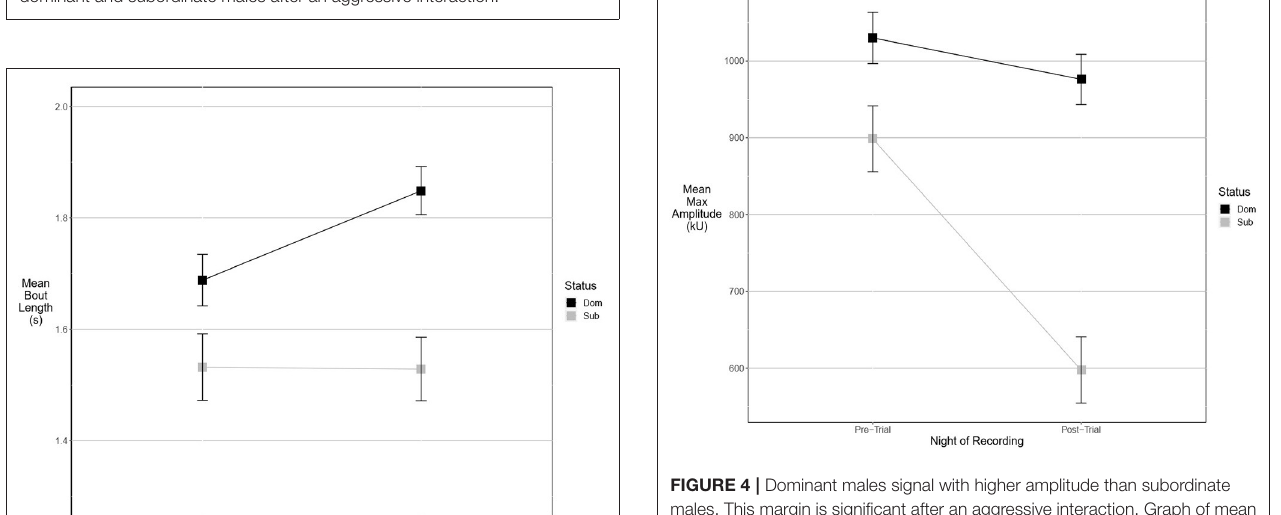
FIGURE 1 | Dominant males are significantly less likely to signal the night before an aggressive interaction, but there is no difference between dominant and subordinate males after an aggressive interaction.